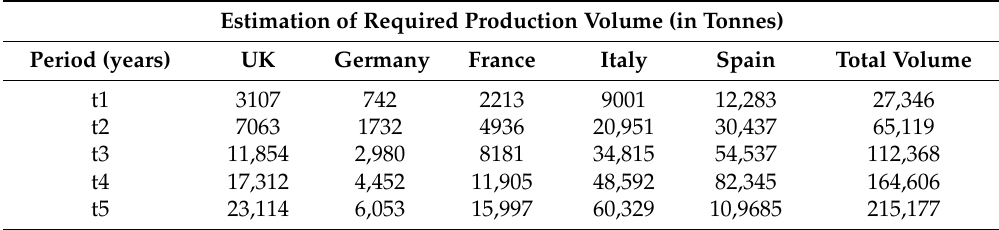
Table 4. Sprinkler internationalization strategy and required production